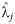
RECC of accidents in the nine main motorways with origin in Mexico City considered altogether.A: The accident rates (λ^j) and group sizes (q^j). B: Cumulative accident rates (blue) and the Lorenz curve (in yellow). The RECC is represented by (twice) the area between the two curves.